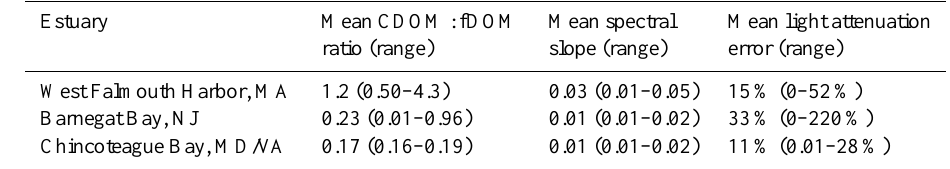
Table 2. Light attenuation model parameters and ensuing errors arising from usage of estuary-wide mean values. Note reduced number of significant figures for reporting of spectral slope as compared to Table S1.